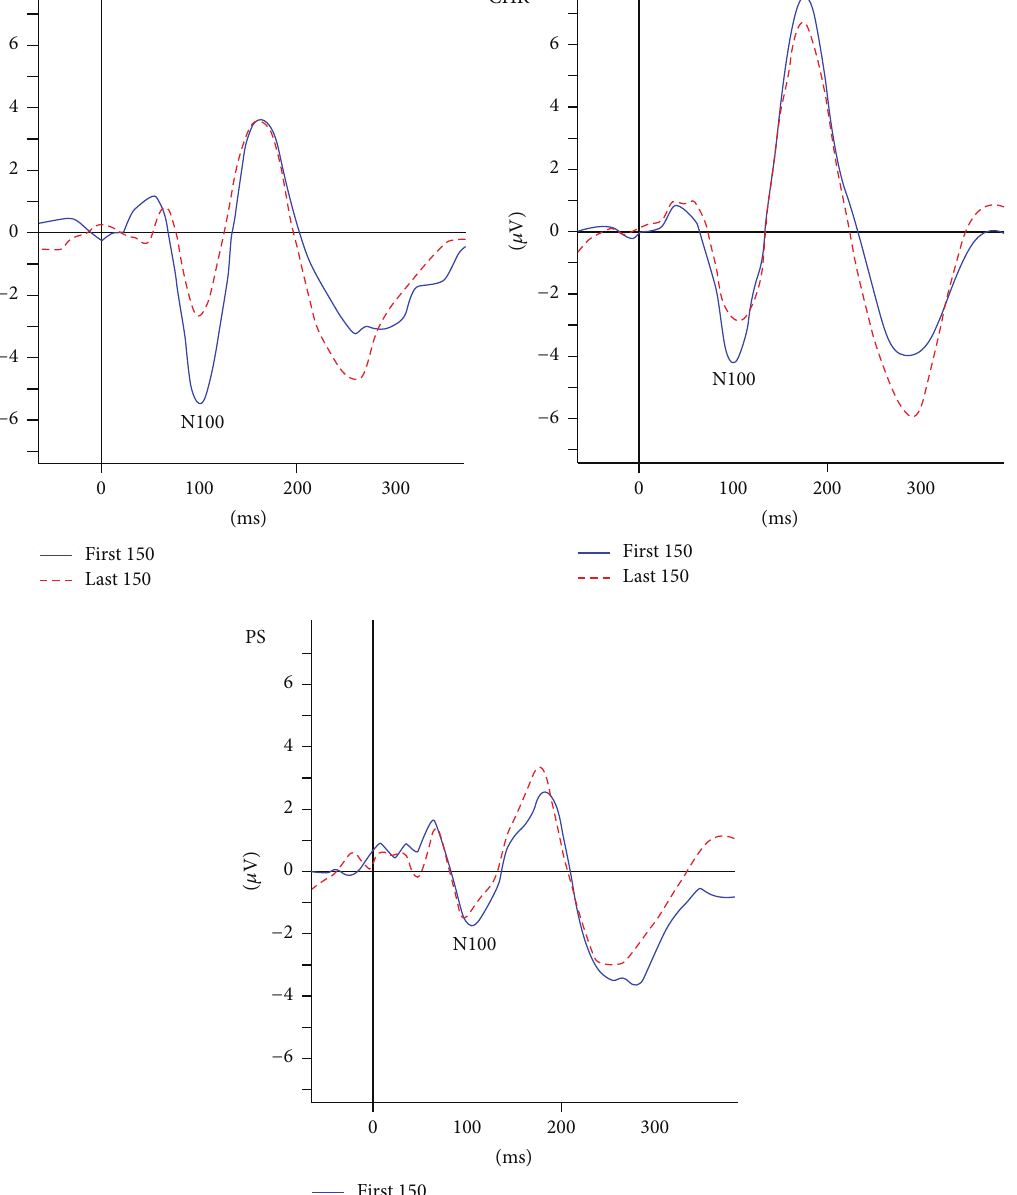
Figure 2: Average auditory N100 response for first and last 150 tones for full sample by clinical group. Auditory stimulus administered at 0 milliseconds. HC: healthy control; CHR: clinical high risk; PS: psychosis. HC > CHR, PS on the difference in the average N100 response to first versus last 150